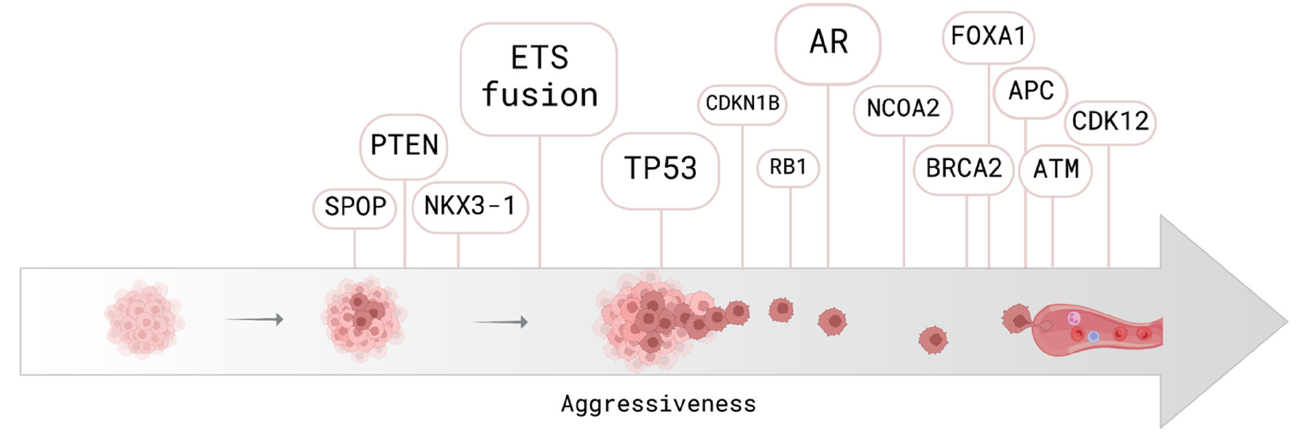
Figure 1. Common mutations detected in PCa are shown according to their occurrence along the disease progression. The bubble size indicates the frequency of mutation. Created with BioRender.com (Accessed on 18 October 2022) .